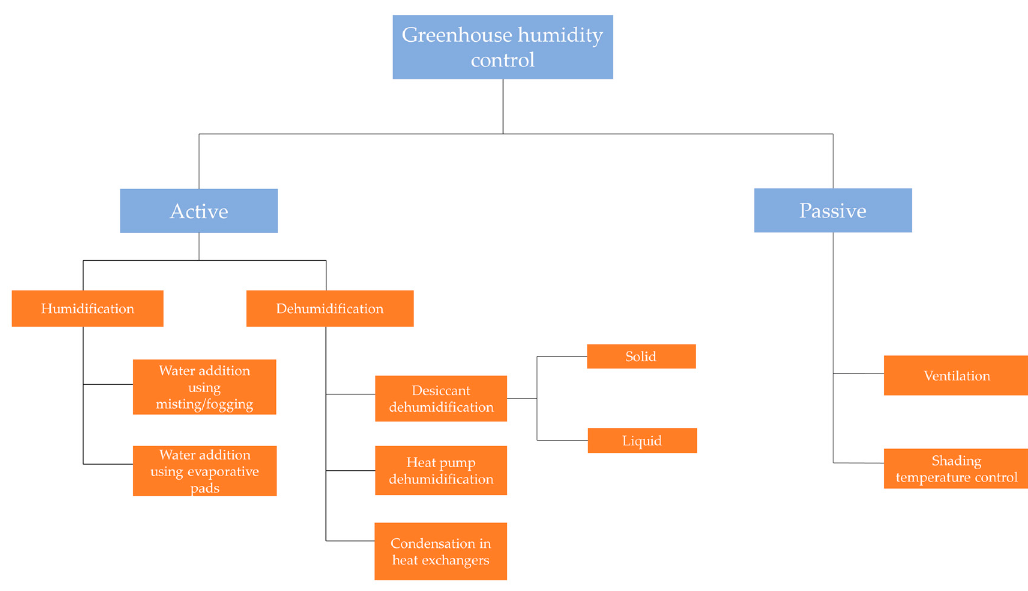
Figure 3. Active and passive humidity control methods for green houses and plant factories. 501